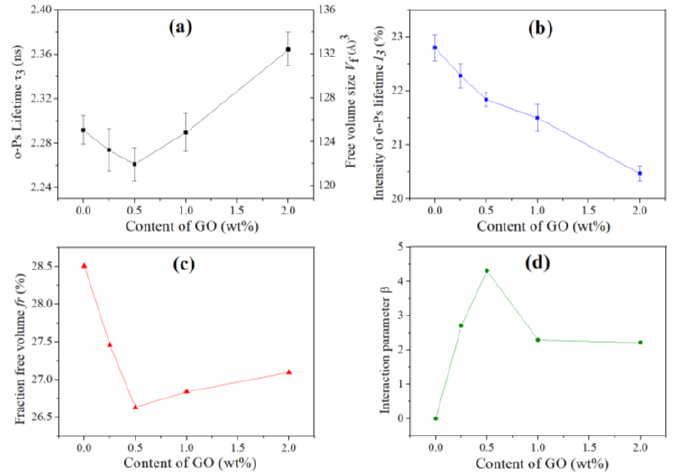
Figure 2. ( a ) o-Ps lifetime τ 3 and free volume size V f , ( b ) o-Ps lifetime intensity I 3 , ( c ) fractional free volume f r , ( d ) interfacial interaction β of the GO/WPU composites [51].